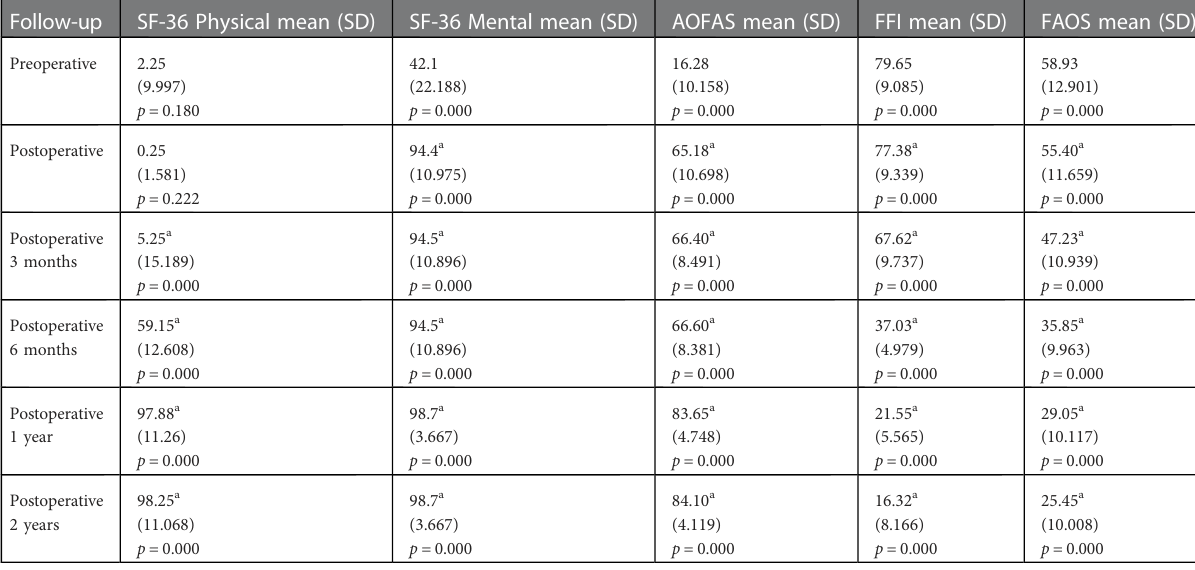
TABLE 2 The mean and standard deviation value of each functional scoring from preoperative, immediate postoperative, and postoperative 3 months, 6 months, 1 year, and 2 years.